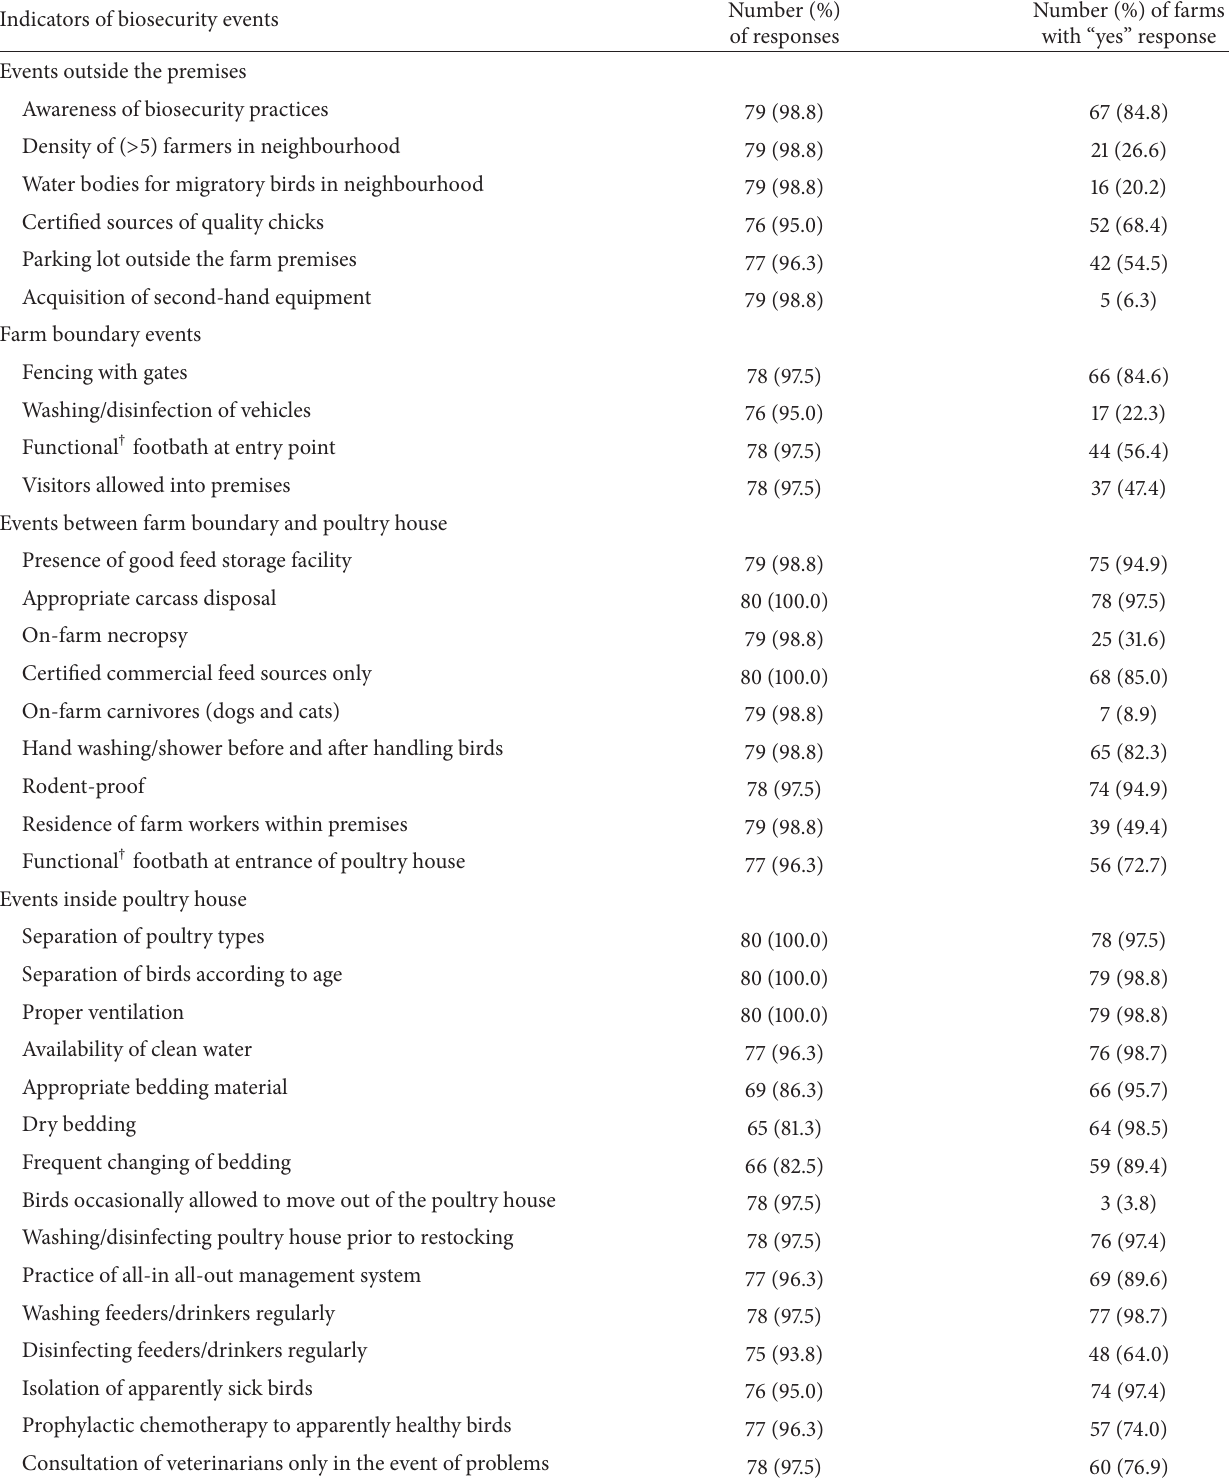
Table 2: Frequency of biosecurity events on poultry farms in Jos,